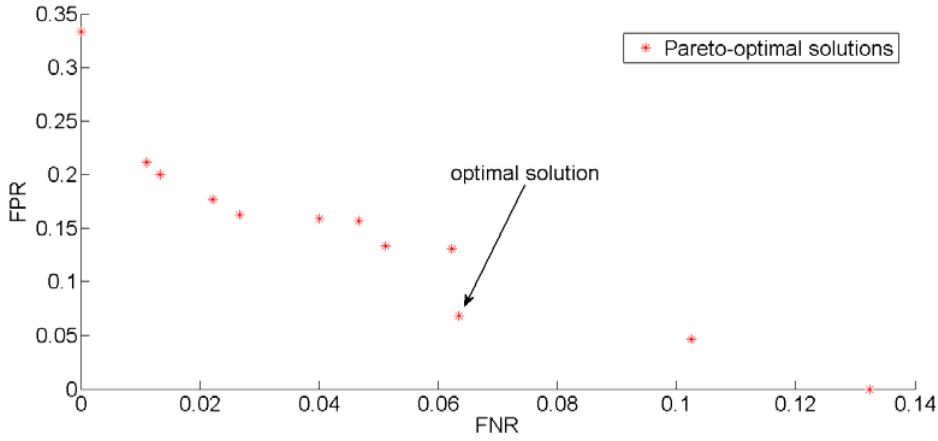
Figure 3. The optimization results for glyphosate-A series with eight sensors.